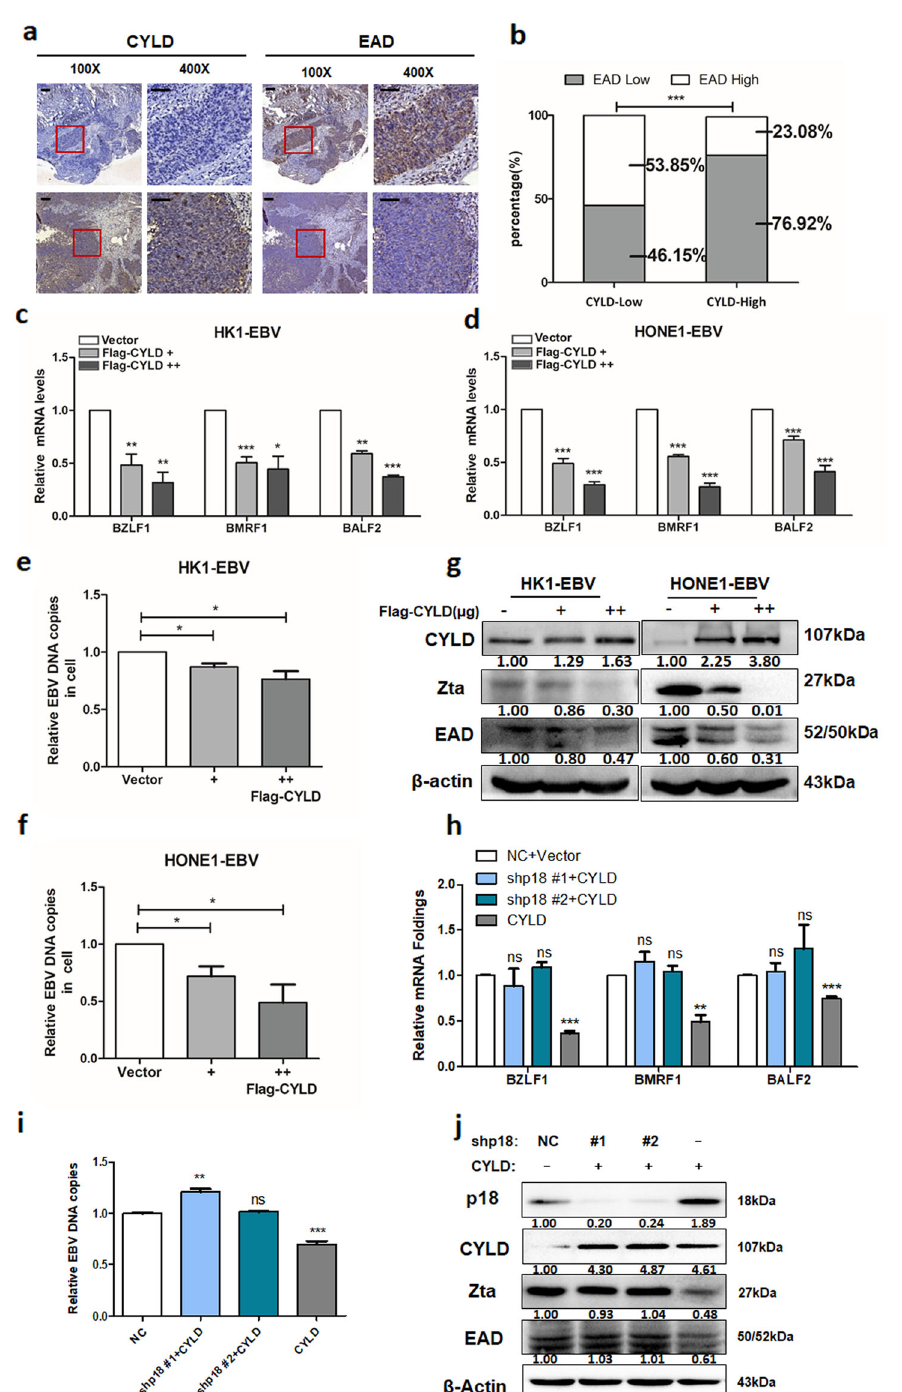
Fig. 6 CYLD inhibits EBV reactivation dependent on p18. a Representative IHC staining of CYLD and EAD expression taken from pathological sections of NPC patients (100×: scale bar, 100 μ m; 400×: scale bar, 50 μ m). b EAD expression level was calculated based on CYLD expression. High and low groups were according to median expression. c , d HK1-EBV and HONE1-EBV cells infected with vector or CYLD and total RNA from cells was isolated and subjected to real-time PCR. e , f Real-time PCR showing EBV DNA copy levels of EBV in HK1-EBV and HONE1-EBV cells. HONE1-EBV cells were infected with p18 lentiviral shRNAs and then transfected with the indicated constructs. g Cell lysates were then extracted and subjected to Western blotting. h Total RNA and i gDNA were isolated and subjected to real-time PCR. j Cell lysates were immunoblotted with antibodies against the indicated proteins. β -Actin was used as a control to con fi rm equal loading of protein. (Data are represented as mean ± SEM ( n = 3). Differences were considered signi fi cant at * p < 0.05, ** p < 0.01, *** p <